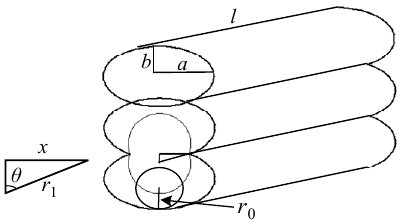
Figure 2. Schematic diagram of the formation of the horizontal bonding